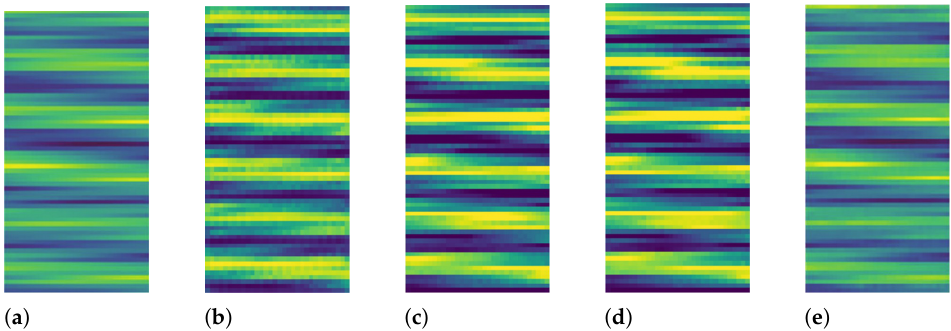
Figure 6. Channel-estimation visualization using several algorithms. ( a ) Real channel. ( b ) LS estimated channel. ( c ) MMSE estimated channel. ( d ) cGAN estimated channel. ( e ) N2N-cGAN estimated channel.